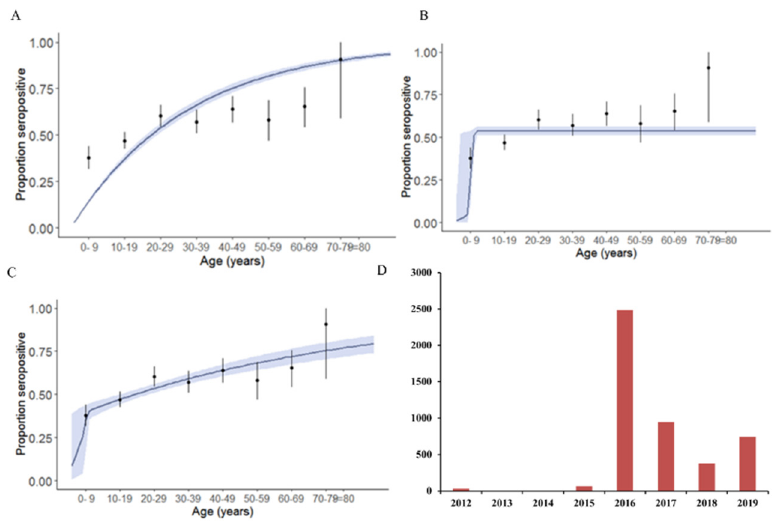
Figure 4. Seroprevalence of chikungunya predicted under different models: ( A ) constant model; ( B ) outbreak model; ( C ) combination of constant and outbreak model. Black line within the envelope (blue shade) represents force of infection and the envelope represents the 95% confidence intervals. Vertical line with black dots represents the observed seroprevalence with 95% CI. ( D ) represents the cumulative number of cases reported to Pune Municipal Corporation during the years 2012–2019 .